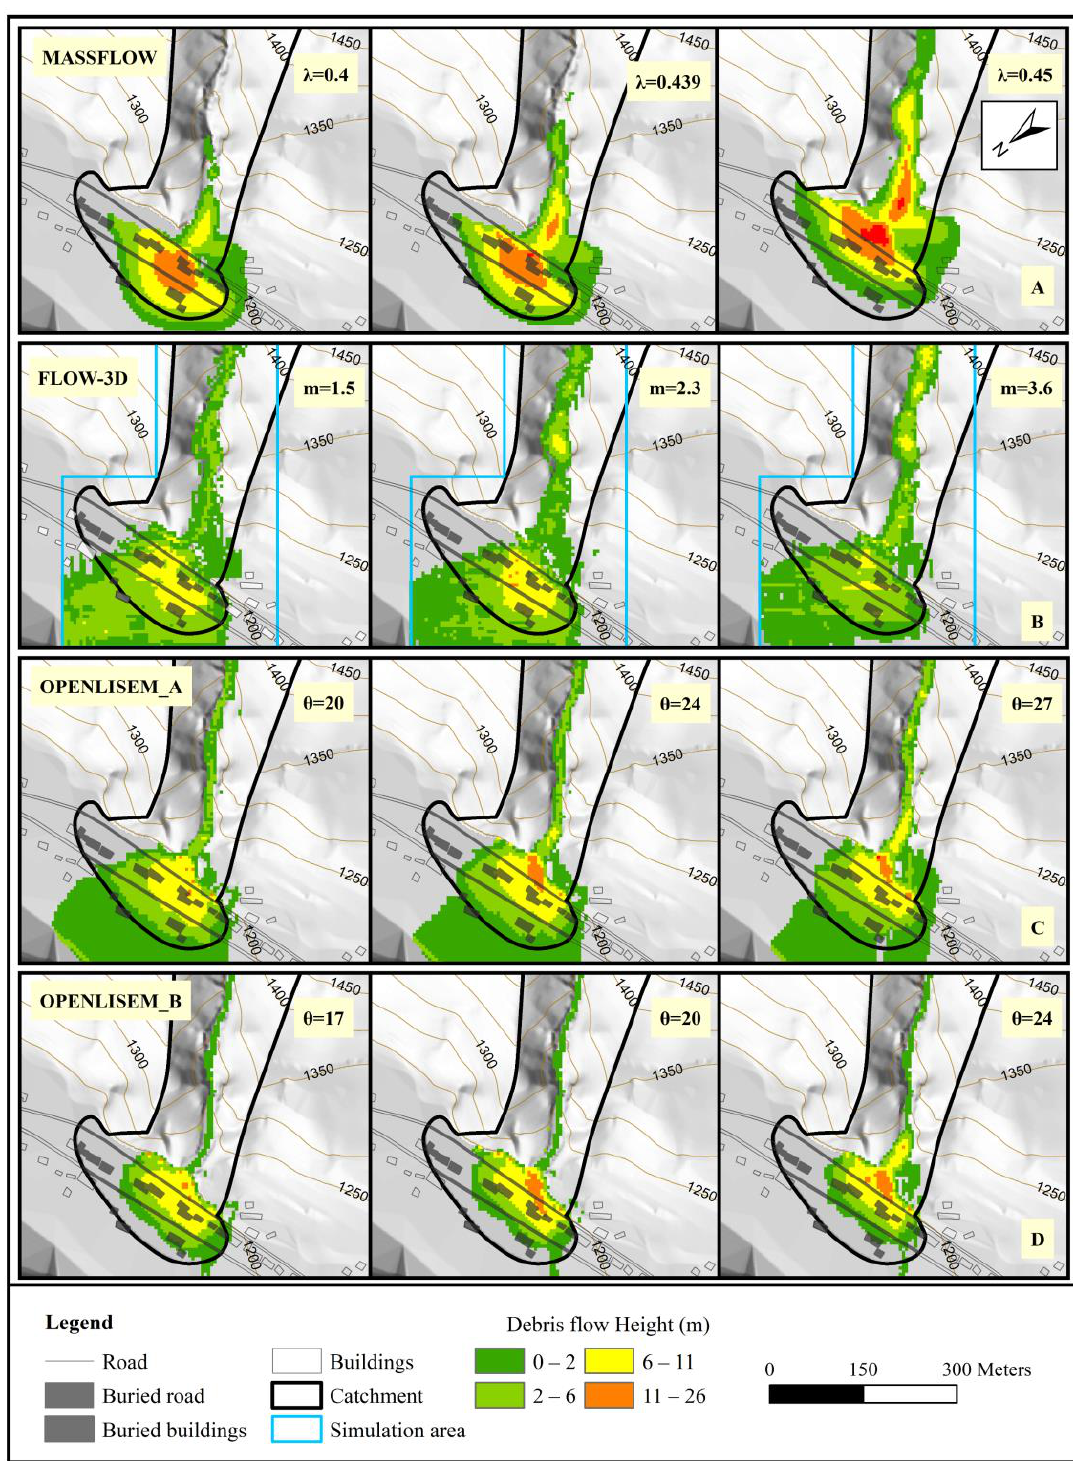
Figure 6. Wayao debris flow fan reproduced by four models. ( A ) Massflow simulations-sensitivity to the Coulomb-type friction µ = 0.4, µ = 0.439, and µ = 0.45. ( B ) Flow-3D simulations-sensitivity to multiplier in internal friction angle θ = 20, θ = 32, and θ = 35. ( C ) OpenLISEM_A simulations- sensitivity to internal friction angle θ = 20, θ = 24, and θ = 27. ( D ) OpenLISEM_B simulations- sensitivity to internal friction angle coefficient θ = 17, θ = 20, and θ = 24.